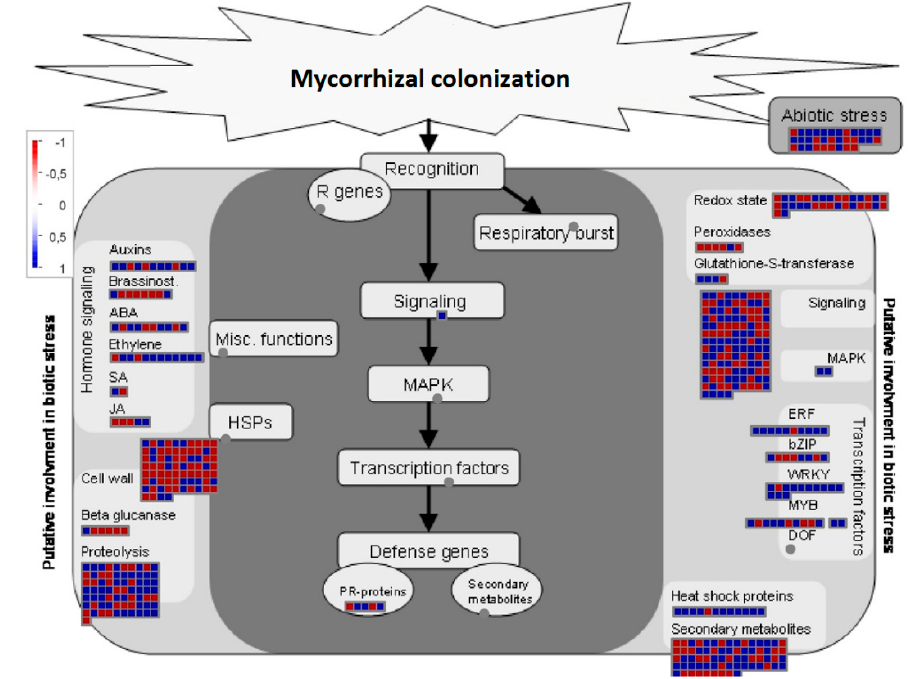
Figure 6. Biotic stress responses are illustrated by MapMan [29] and based on the list of differentially regulated genes in Oeceoclades maculata roots (Table S7). Blue squares represent genes up-regulated, whereas red squares represent genes down-regulated in mycorrhizal roots, as compared with non-mycorrhizal roots. A scale is on the left.